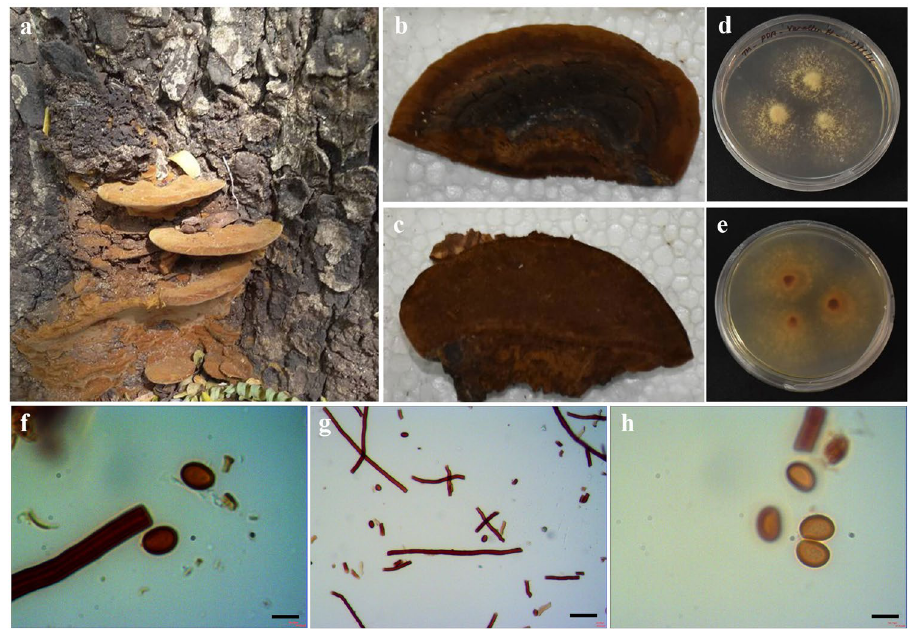
Figure 9. Morphology of Fulvifomes fastuosus : ( a ) Basidiomata attached to the host; ( b ) Pileal surface; ( c ) Hymenial surface; ( d , e ) Pure culture; ( f ) Skeletal Hyphae; ( g ) Generative hyphae; ( h ) Basidiospores. (Scale: 40X– g; 100X– f &